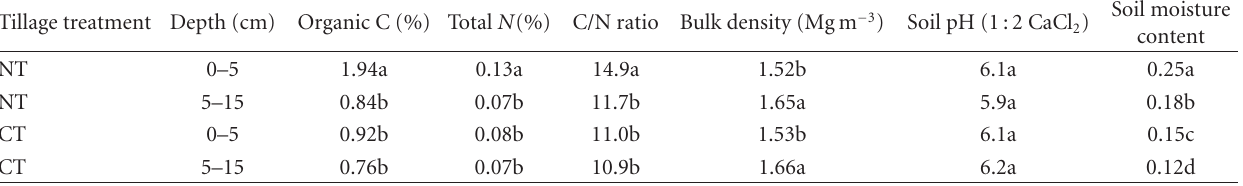
Table 1: Selected chemical and physical properties of soils from no-till (NT) and conventional-till (CT) treatments ∗ .